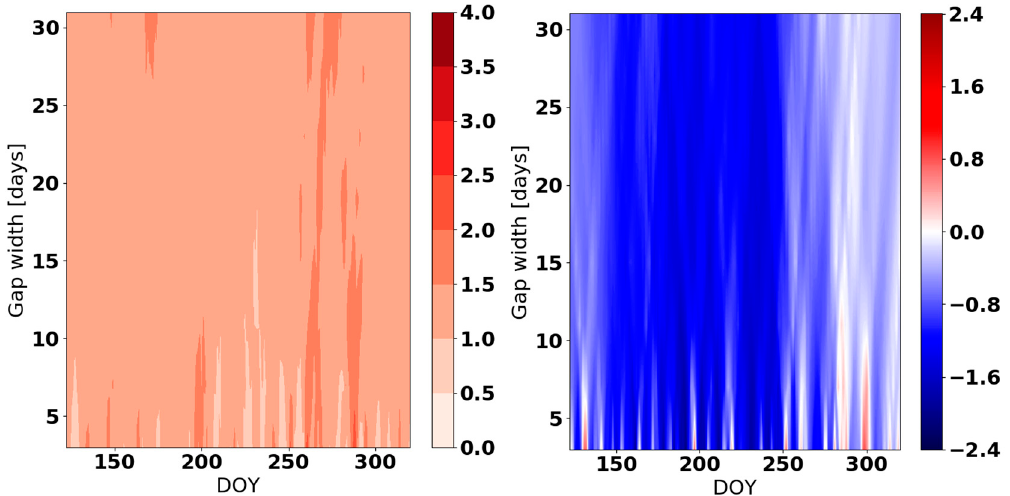
Figure 15. RMSE DEB ( left panel ) and (RMSE DEB -RMSE ERA5 ) difference ( right panel ) for DOY 122–320in 2016 in Montecristo Island (Italy).